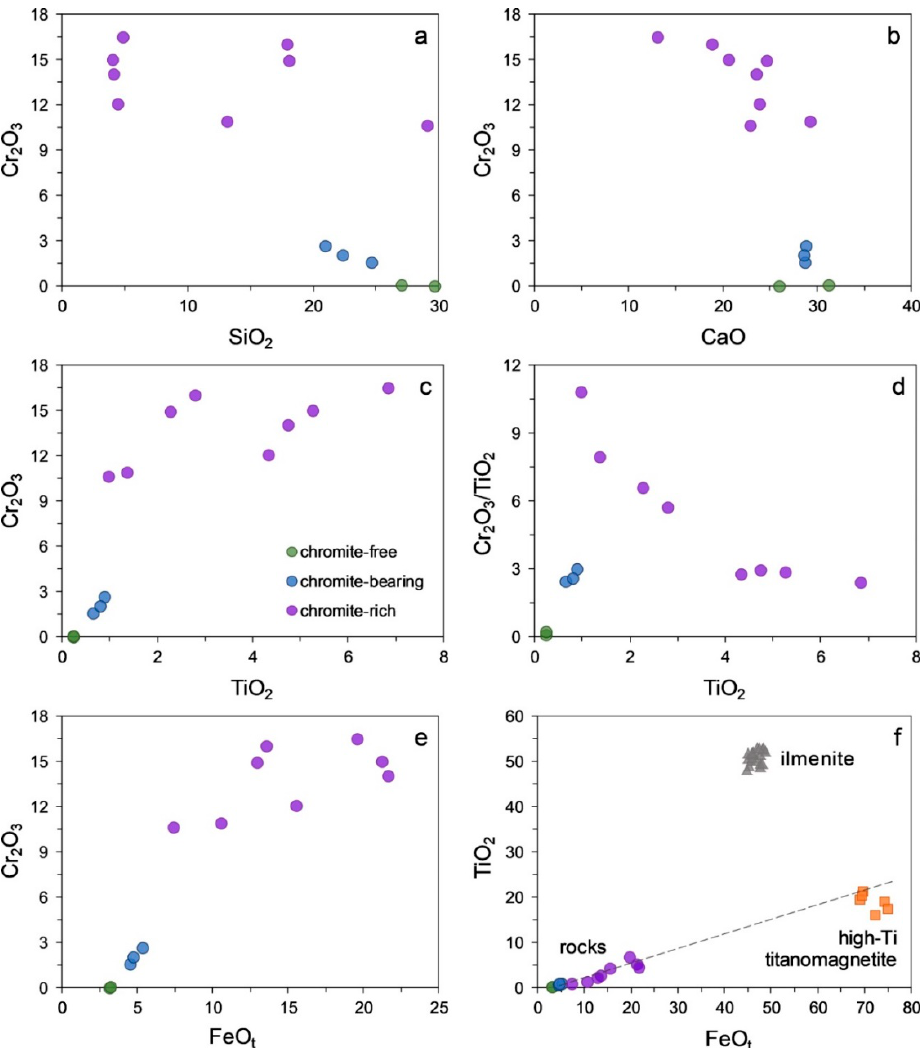
Figure 5. Binary diagrams for chromite-free, chromite-bearing and chromite-rich sandstones, ilmenite and high-Ti titanomagnetite from Sabantuy paleoplacer (in wt.%): SiO 2 vs. Cr 2 O 3 ( a ), CaO vs. Cr 2 O 3 ( b ), TiO 2 vs. Cr 2 O 3 ( c ), FeO t vs. Cr 2 O 3 /TiO 2 ( d ), FeO t vs. Cr 2 O 3 ( e ), FeO t vs. TiO 2 ( f ). Note: FeO t = FeO + Fe 2 O 3 .